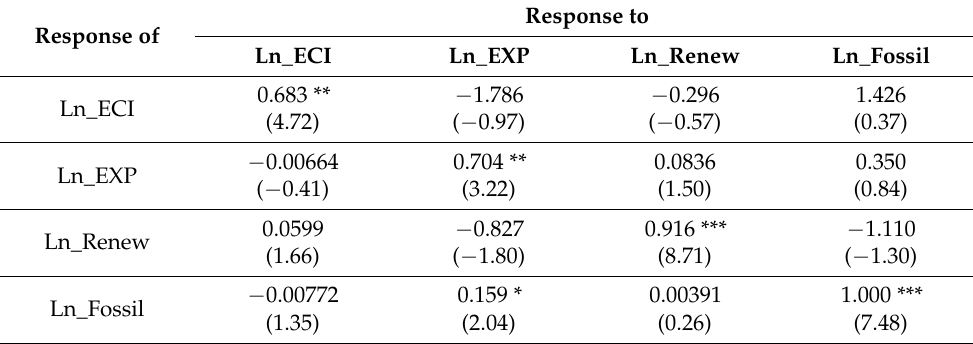
Table 5. Results of PVAR analysis.